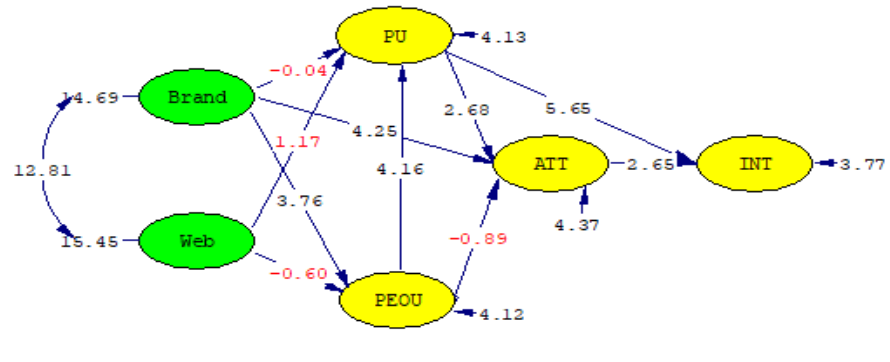
Table 3: Summary of hypotheses testing and fit